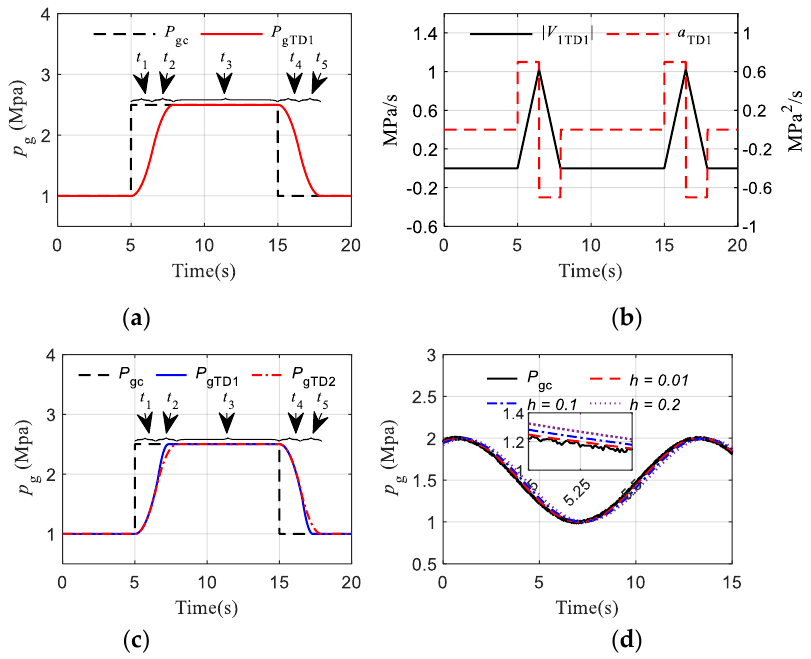
| | V and a ; ( c ) The 1 1 TD 1 TD